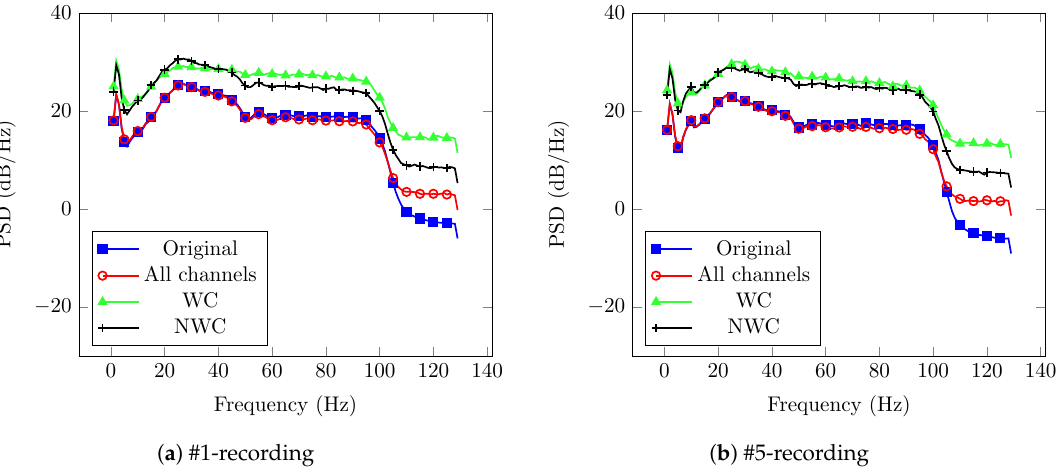
Figure 6. PSD results from EnKF outputs of User